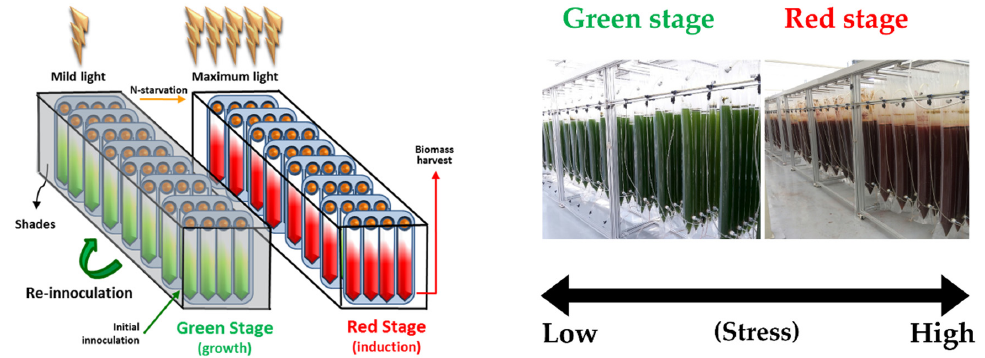
Figure 2. Schematic illustration and actual photographs of two-stage strategy.